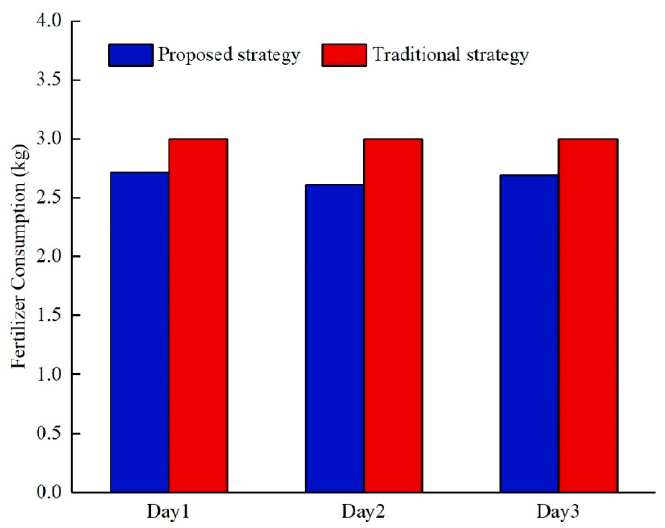
Figure 9. Comparative results for fertilizer consumption.